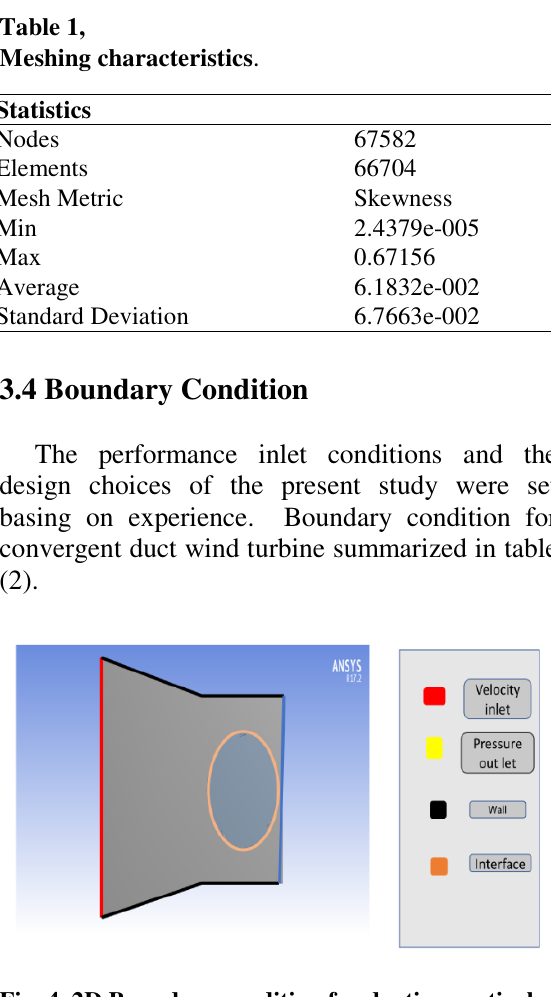
Fig. 4. 2D Boundary condition for ducting vertical axis wind